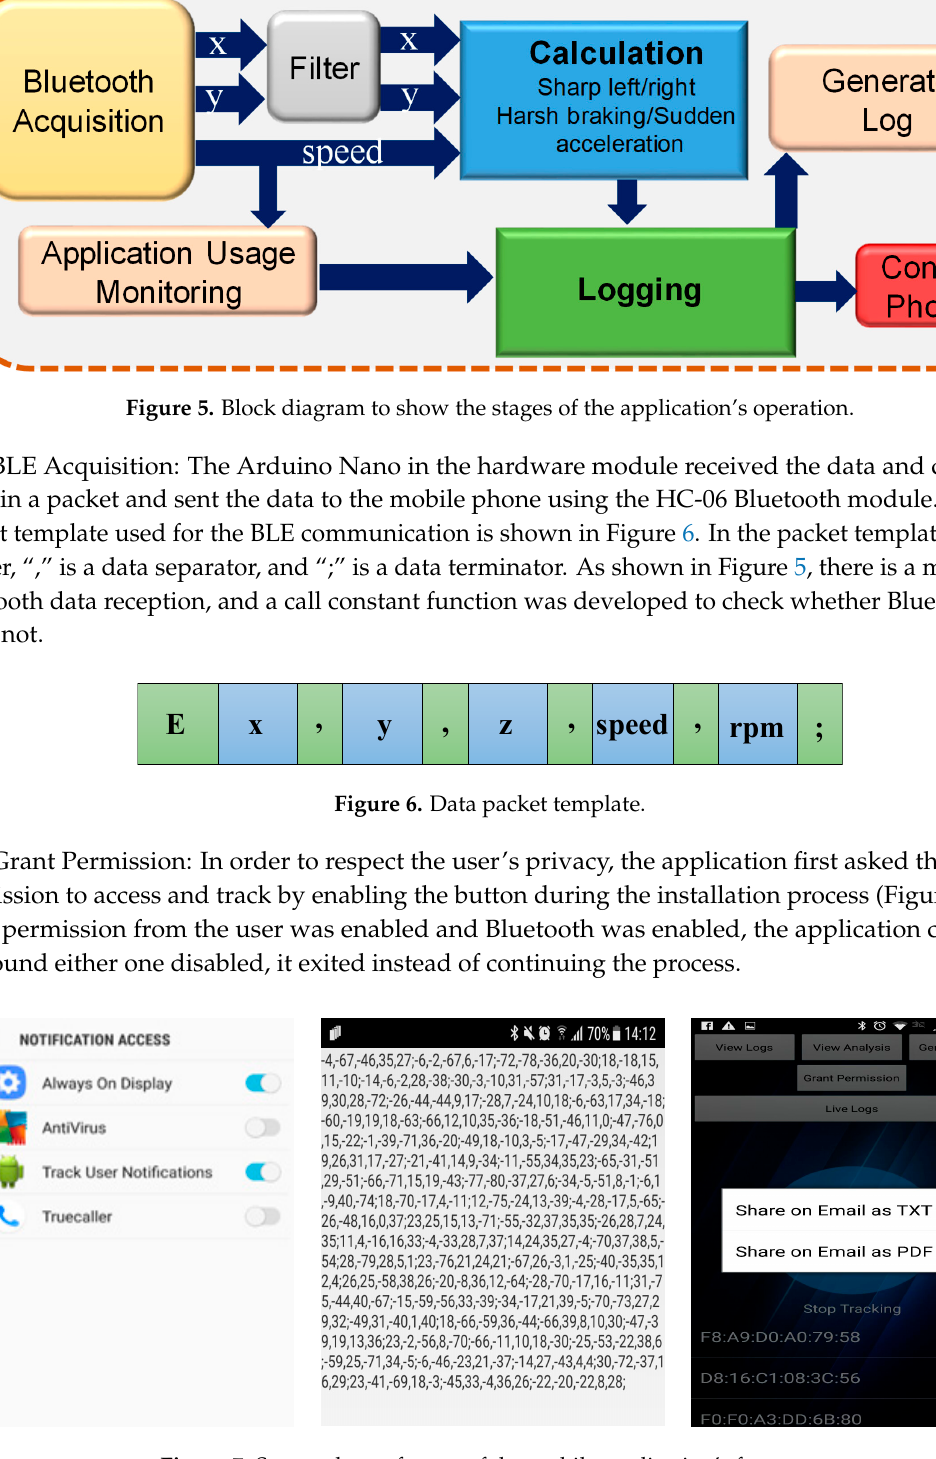
Figure 7 . Screen shots of some of the mobile application’s features. Figure 7. Screen shots of some of the mobile application’s